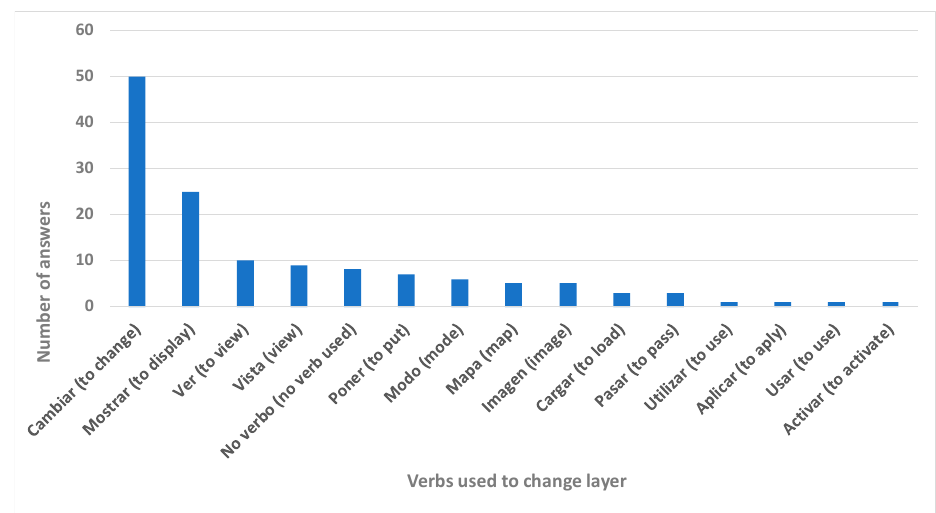
Figure 6. Requests to change layer functionality.